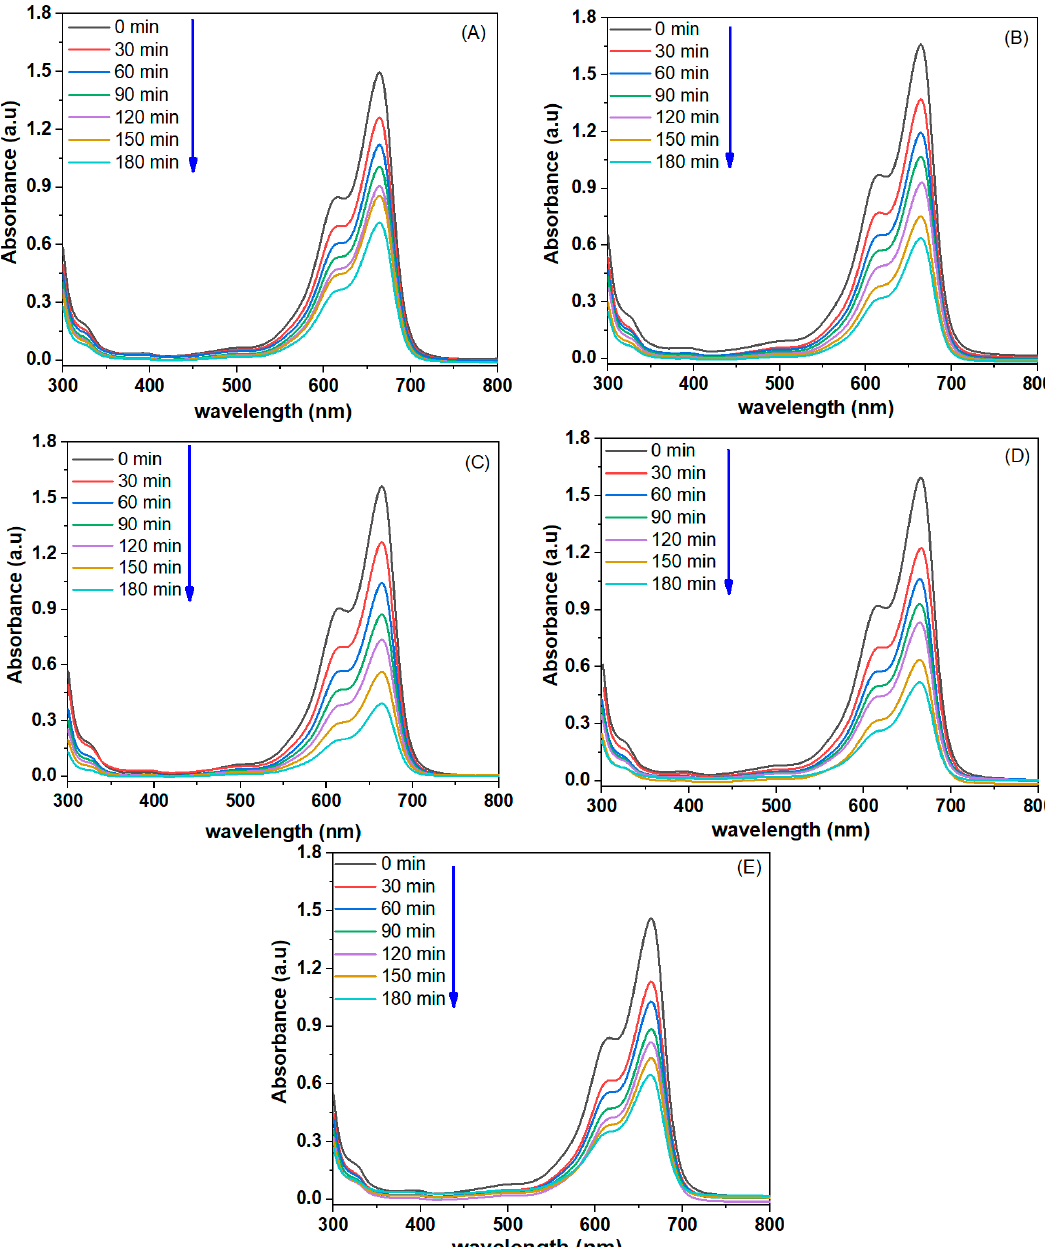
Figure 9. The UV light absorbance of MB solutions as a function of irradiation time ( A ) pure MgO NPs, ( B ) 1% Ag, ( C ) 2% Ag, ( D ) 5% Ag, ( E ) 7.5% Ag ‐ doped MgO NPs. Results suggested that the rate constant of 2% Ag ‐ doped MgO NPs was almost two ‐ fold higher than pure MgO NPs. Figure 10C illustrates the efficiency of MB degra ‐ dation of pure MgO NPs and Ag ‐ doped MgO NPs. Results showed that the efficiency of MB degradation of the prepared samples was up to 52% to 75% for 180 min, respectively, which is consistent with a previous study [18]. Surprisingly, 2% Ag ‐ doped MgO NPs (Figure 10A) has shown maximum degradation of MB dye as compared to 1%, 5%, and 7.5% Ag ‐ MgO NPs. This could be due to maximum migration of charge carriers for 2% Ag doping at the surface of MgO NPs. Higher photocatalytic activity after 2% Ag doping in MgO NPs was also reported in other studies [20,22,51–53]. Table 2 shows the compar ‐ ison of degradation efficiency for various photocatalysts on MB dye. These results show